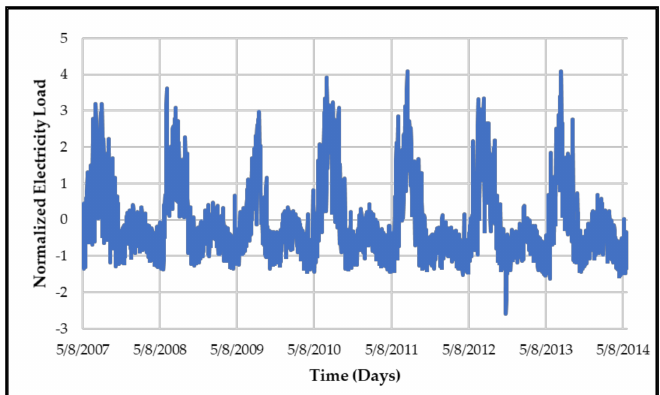
Figure 10. Normalized daily electricity load in NYISO